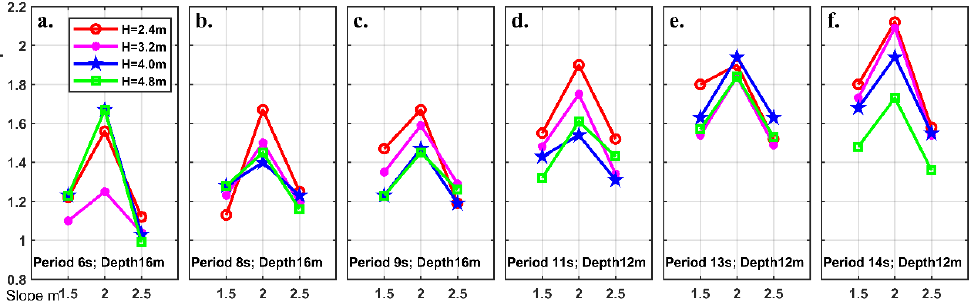
Figure 13. Numerical results for slope versus the wave run-up under various wave heights ( a ) T = 6 s, D = 16 m; ( b ) T = 8 s, D = 16 m; ( c ) T = 9 s, D = 16 m; ( d ) T = 11 s, D = 12 m; ( e ) T = 13 s, D = 12 m; ( f ) T = 14 s, D = 12 m).